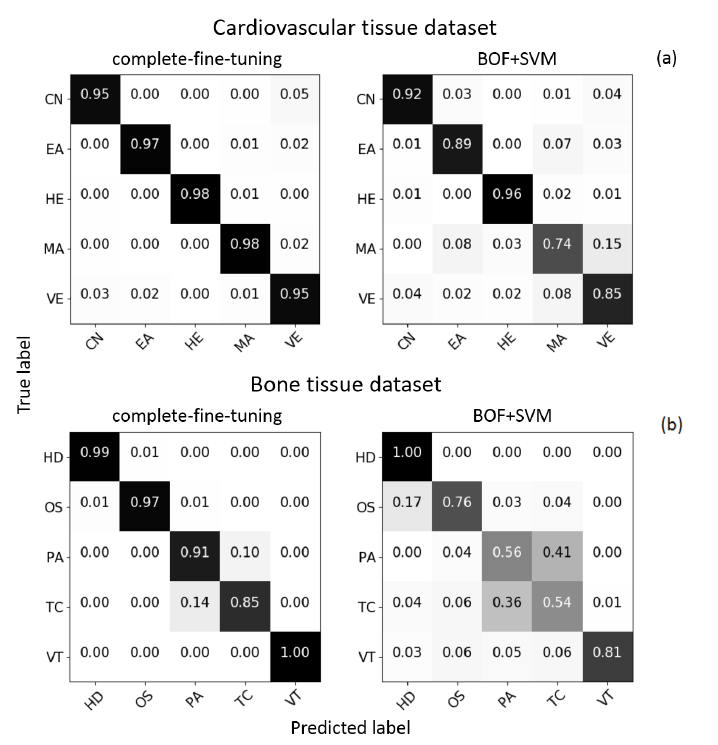
Figure 11. Confusion matrices on the cardiovascular ( a ) and bone ( b ) tissue datasets, respectively of a CNN with complete fine-tuning and of a BOF + SVM framework.